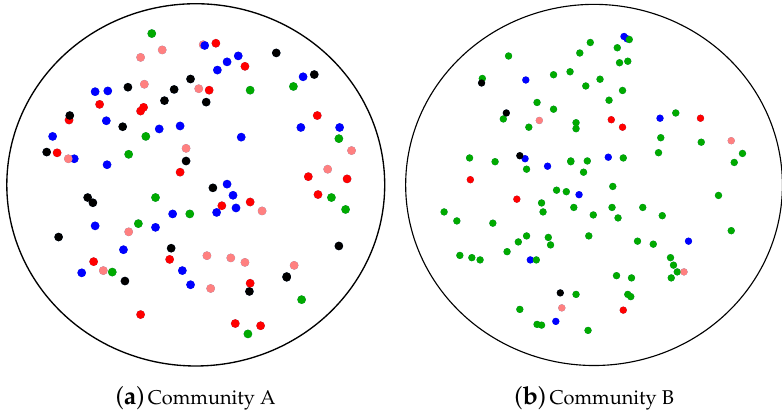
Figure 1. Representation of two communities of 100 individuals of different species, indicated by their colour. Richness is the absolute number of species in a community: in both communities it is equal to five. Evenness is the equitability of the species abundance distribution: in Community A all species are present in equal abundances and so it is perfectly even, while Community B is very uneven since it is dominated by the green species. The disparity is the level of similarity between species: for example, the red and the pink species are more similar in colour than the red and the black